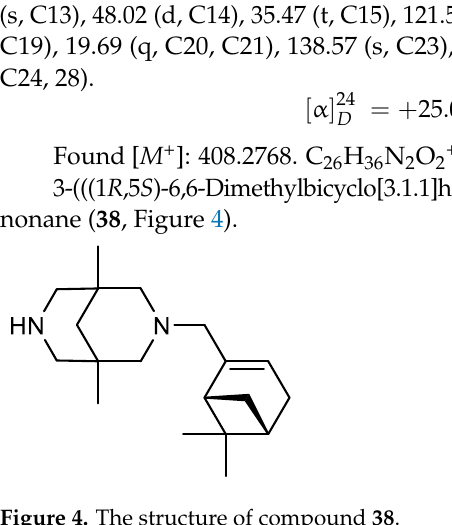
mg). The residual mixture was separated on silica gel in a chloroform:ethanol system, but no other components of the mixture could be isolated individually. 1 H NMR (400 MHz, CDCl 3 , δ, ppm, J , Hz): 0.78 (s, 3H, C 20 H 3 or C 21 H 3 ), 0.87 and 0.88 (s, 6H, C 10 H 3 , C 11 H 3 ), 1.01 (d, 1H, J = 8.6, C 19 H a ), 1.26 (s, 3H, C 20 H 3 or C 21 H 3 ), 1.30 (m, 1H, C 9 H), 1.46 (m, 1H, C 9 H’), 1.8 3 (dd, 1H, 2 J = 11.6, J = 3.2, C 15 H), 1.96 (s, 1H, NH), 2.08 (m, 2H, C 16 H, C 18 H), 2.21 – 2.34 (dm, 3H, C 2 H, C 4 H, C 15 H’ ), 2.41 (m, 2H, C 2 H’, C 4 H’ ), 2.65 (dm, 1H, C 19 H), 2.84 (m, 2H, C 6 H, C 8 H), 2.93 (m, 2H, C 6 H’, C 8 H’ ), 3.10 (dm, 1H, C 12 H), 3.22 (dm, 1H, C 12 H), 5.31 – 5.35 (m, 1H, C 14 H). 13 C NMR (100 MHz, CDCl 3 , δ, ppm): 24.73 (s, C1, C5), 55.31 (t, C6, C8), 64.80 (t, C2, C4), 44.25 (t, C9), 20.46 (q, C10, C11), 63.10 (t, C12), 136.98 (s, C13), 123.66 (d, C14), 30.47 (t, C15), 40.28 (d, C16), 37.28 (s, C1 7′ ), 44.21 (d, C18), 31.50 (t, C19), 26.01 (q, C20), 21.18 (q, C21). [α] 𝐷25 = +0.33 (C = 0.6, CHCl 3 ) Found [ M + ]: 288.2564. C 19 H 32 N 2+ . Calculated [ M + ]: 288.2560. 1,5-Dimethyl-3,7-bis((( S )-4-(prop-1-en-2-yl)cyclohex-1-enyl)methyl)-3,7-diazabicycl o[3.3.1]nonan-9-one ( 42 , Figure 5). Figure 5. The structure of compound 42 with atom numbering scheme. A mixture of 476 mg (1.97 mmol) of bispidinonehydrochloride 16 , 2.5 eq of bromide 28 and 6 eq of K 2 CO 3 in 4 mL acetonitrile was heated in a microwave reactor to 75 °C and allowed to stand for 90 min. After cooling of the reaction mixture, the precipitate was separated, washed with ethyl acetate. The organic phases were combined, the solvent was evaporated. The product yield after chromatography was 610 mg (71%). 1 H NMR (600 MHz, CDCl 3 , δ, ppm, J , Hz; for the numbering of the atoms, see Figure 5): 0.96 s (6H, C10H3, C11H3); 1.39 – 1.47 m (2H, C 17 H a , C 17 ′H a − ); 1.72 br.s (6H, C 21 H 3 ,